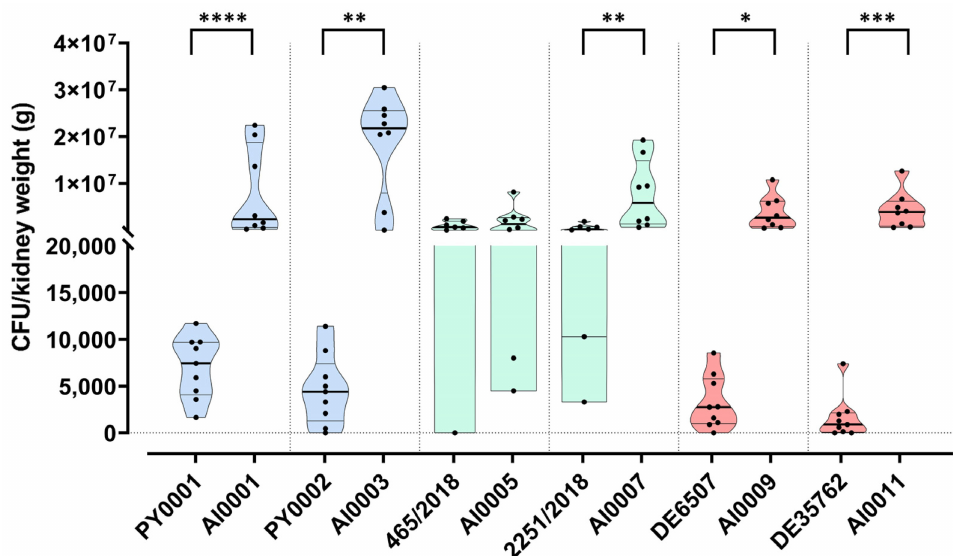
Figure 6. Kidney burden of mice injected with yeast probiotic isolates and HMX1 deletion mutant strains. Individual data points represent the colony forming units per kidney weight (g) for every mouse. Data from mice that died during or were killed at the end of the experiment are both plotted. Horizontal black lines show the median of the datapoints within a dataset. Comparisons with significant differences are marked (*: p < 0.05; **: p < 0.01; ***: p < 0.001; ****: p <